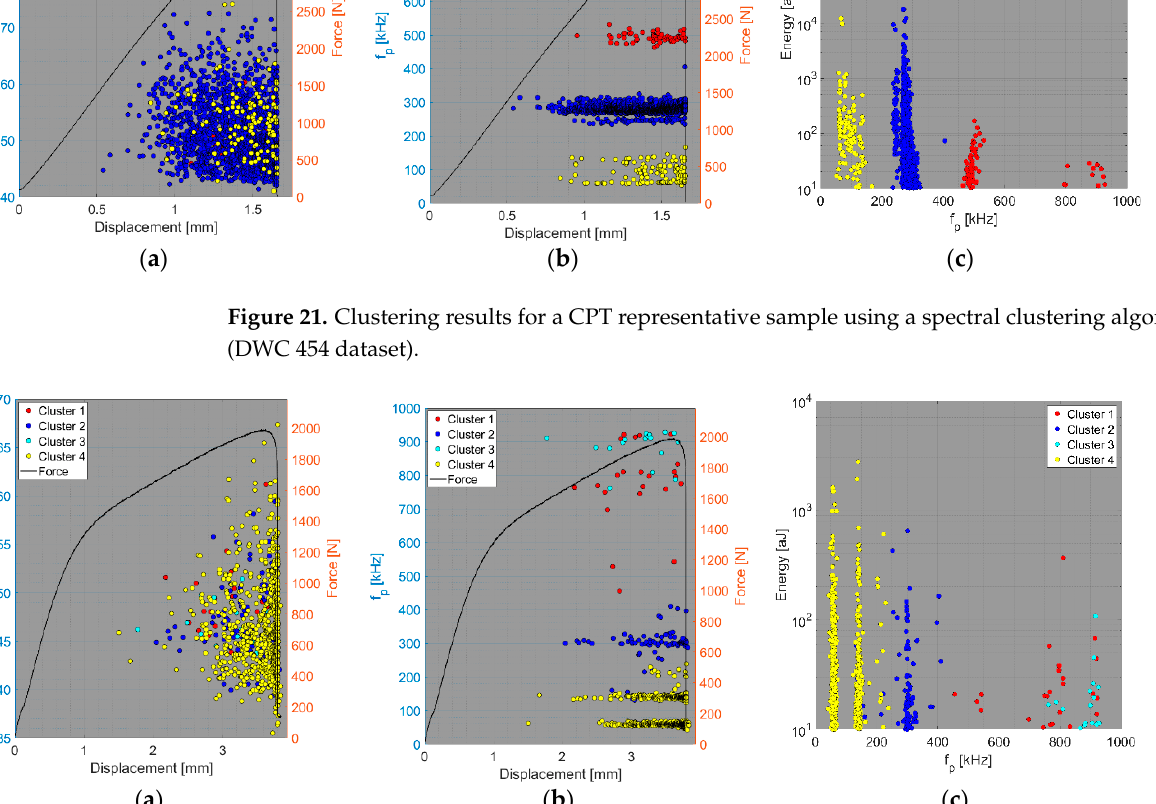
Figure 22. Clustering results for a CPTS representative sample using a spectral clustering algorithm and secondary filtering using a partial power variable (Fujicera 1045S dataset).